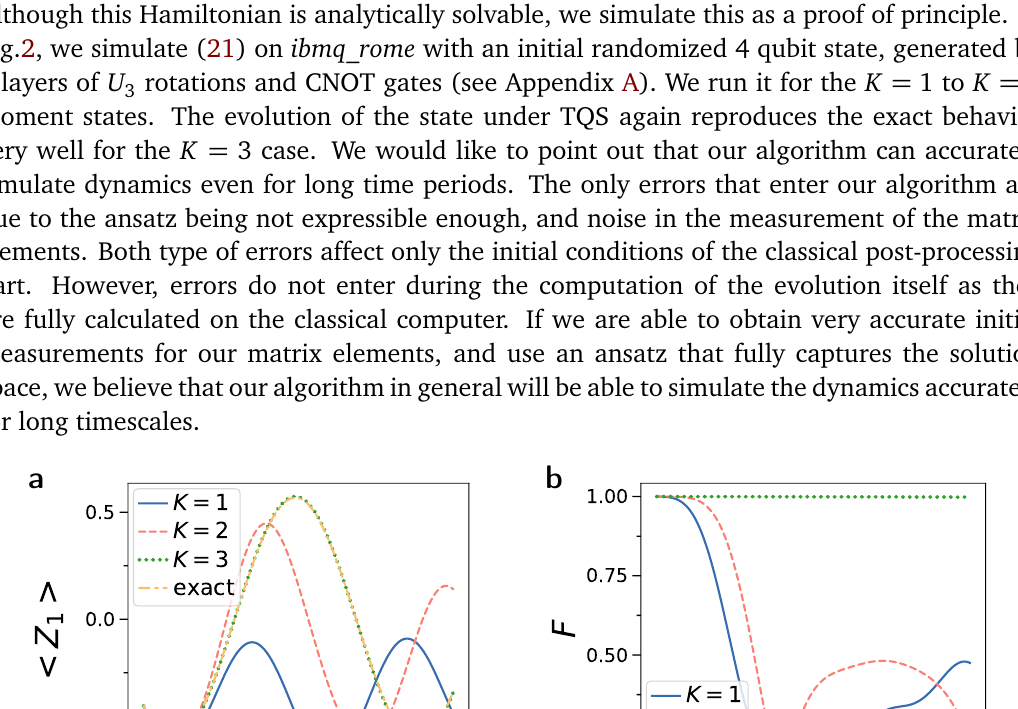
simulated 4 〉 b) Fidelity 1